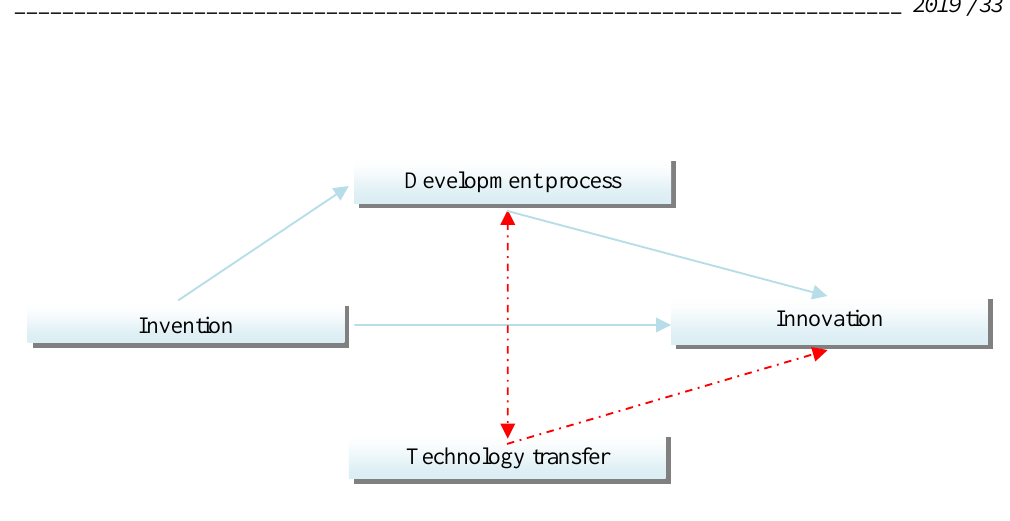
Fig. 2. Elements of innovation (created by the